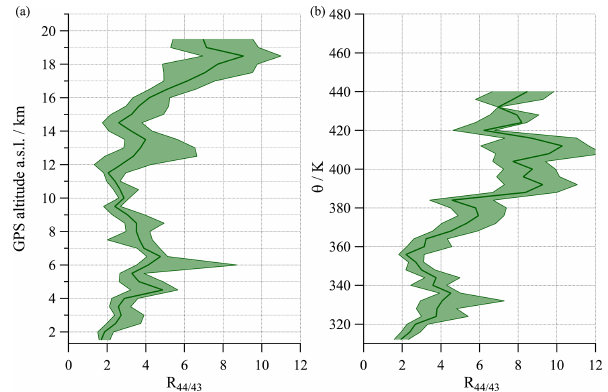
Figure 14. Vertical profiles with median and interquartile ranges of the fraction R 44 / 43 derived from the ERICA-AMS measurements as a function of (a) GPS altitude and (b) potential temperature θ . Values above 18.5km or 420K are uncertain due to low organic sig- nals, which are very sensitive to CO 2 corrections. Only data points are shown where values of organic mass concentration as well as org44 and org43 signals are above the detection limit of the corre- sponding vertical bins. This condition is not fulfilled above 19km and 440K.